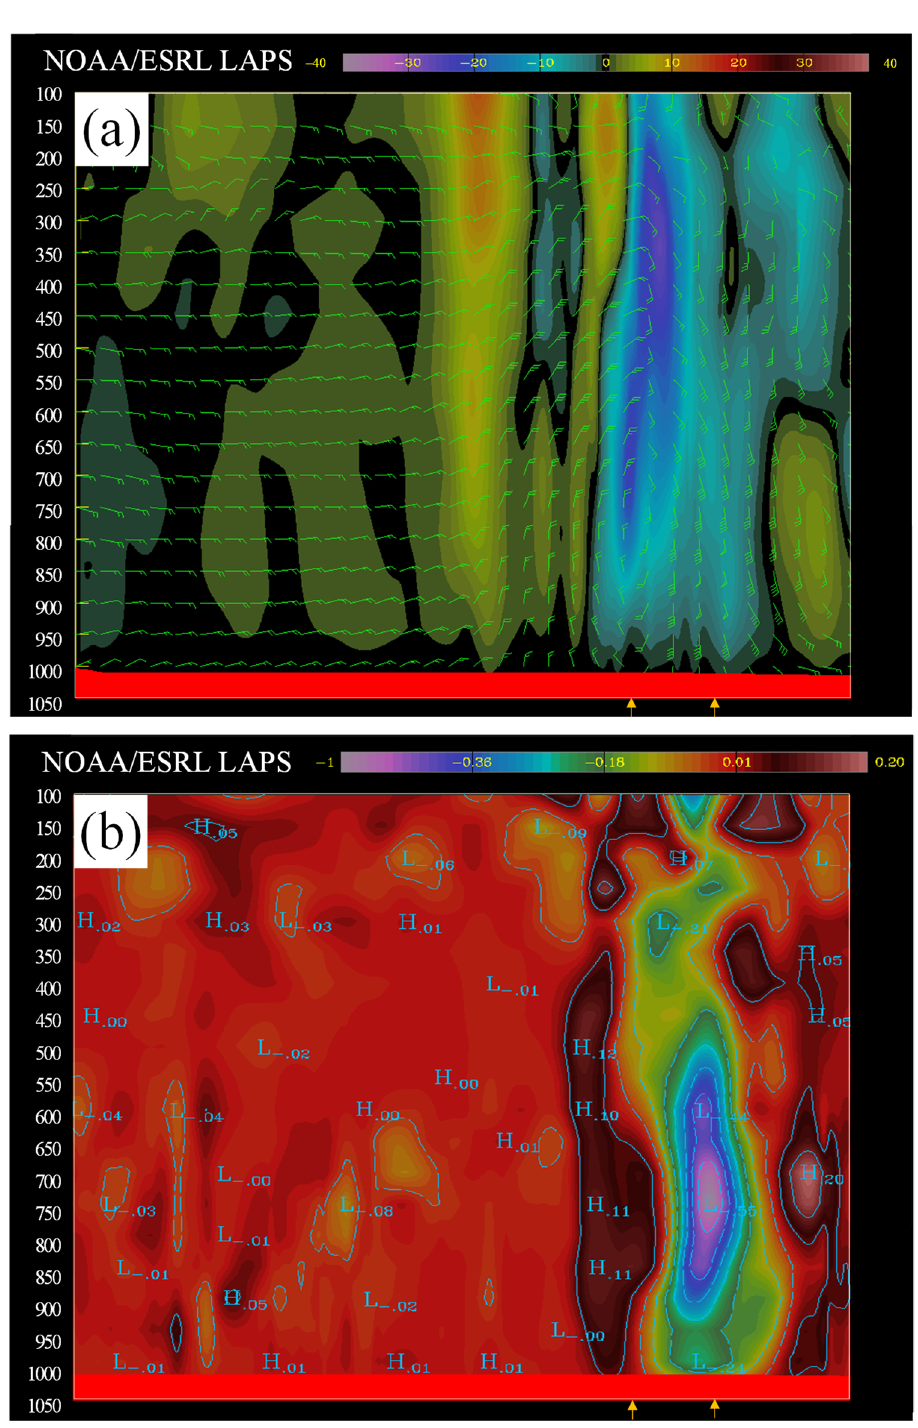
Figure 4. Cross-section of ( a ) wind (knots) and omega ( µ bar s − 1 ) values, and ( b ) geopotential height perturbation differences (0.1 m) between the background and the Hurricane Local Analysis Prediction System (HLAPS) simulation of Hurricane Dennis. Yellow arrows indicate the cyclone center and wall.